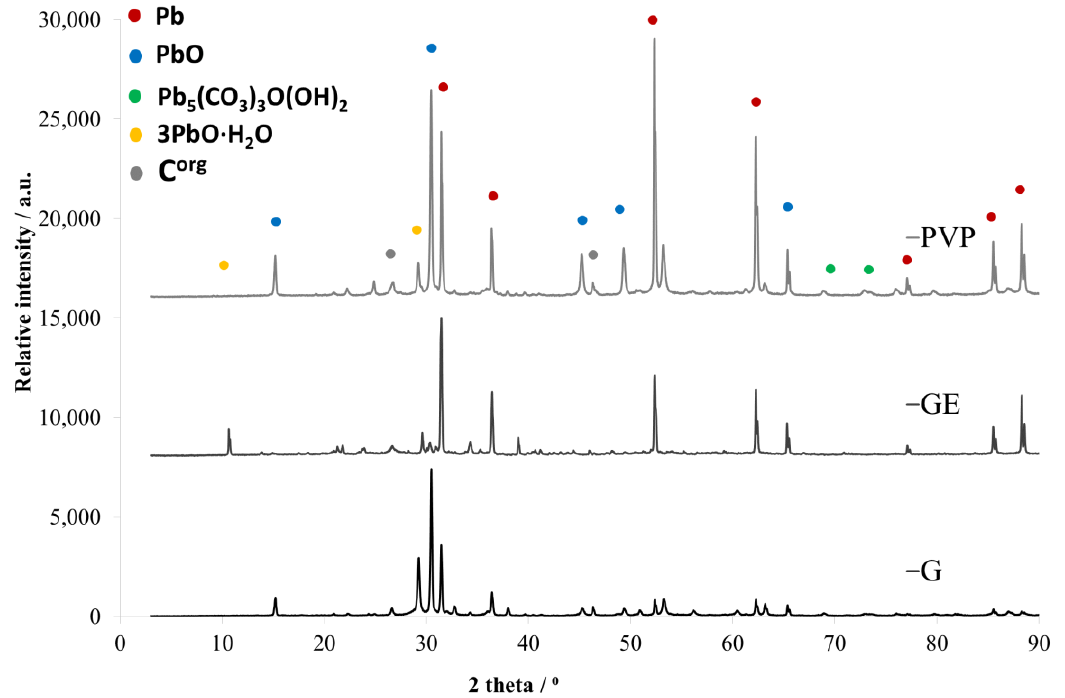
Figure 8. XRD patterns of lead deposits obtained using different inhibitors.